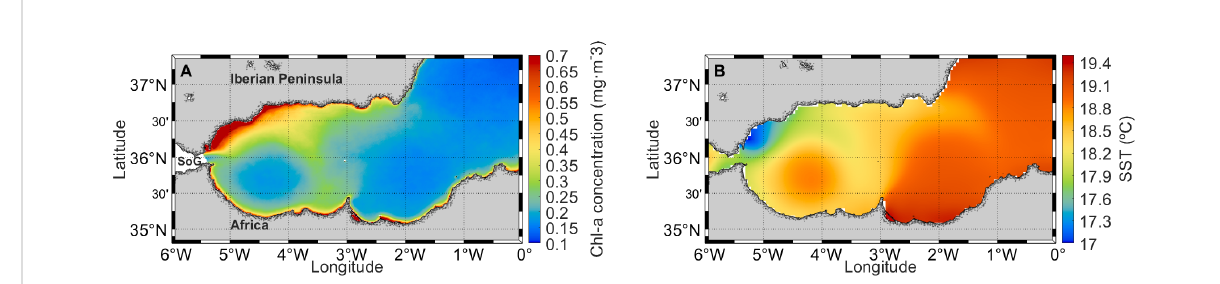
FIGURE 2 (A) Time-mean Chlorophyll-a concentration (mg/m³) over the period 1997 – 2020 in the Alboran Sea, obtained from the CMEMS product OCEANCOLOUR_MED_CHL_L4_REP_OBSERVATIONS_009_078. (B) Time-mean Sea Surface Temperature (SST) over the period 1981 – 2021 in the Alboran Sea, obtained from the product